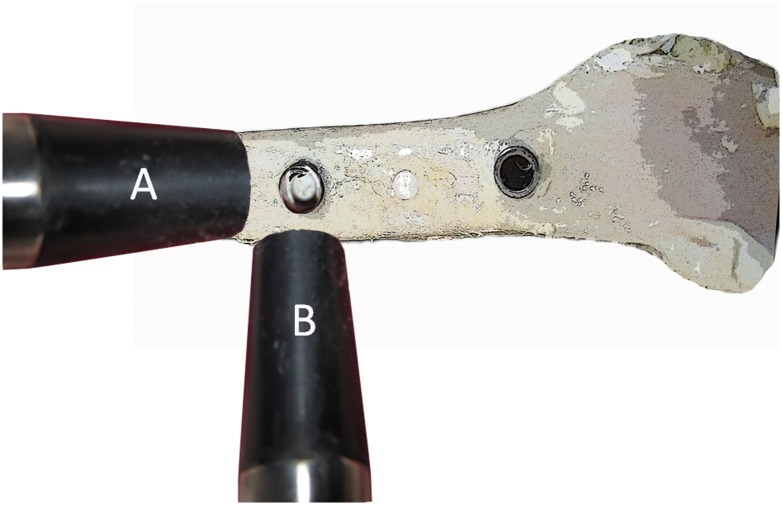
Schematic illustration of the implant stability quotient (ISQ) measurement in 2 directions: (A) disto-proximal and (B) antero-posterior.